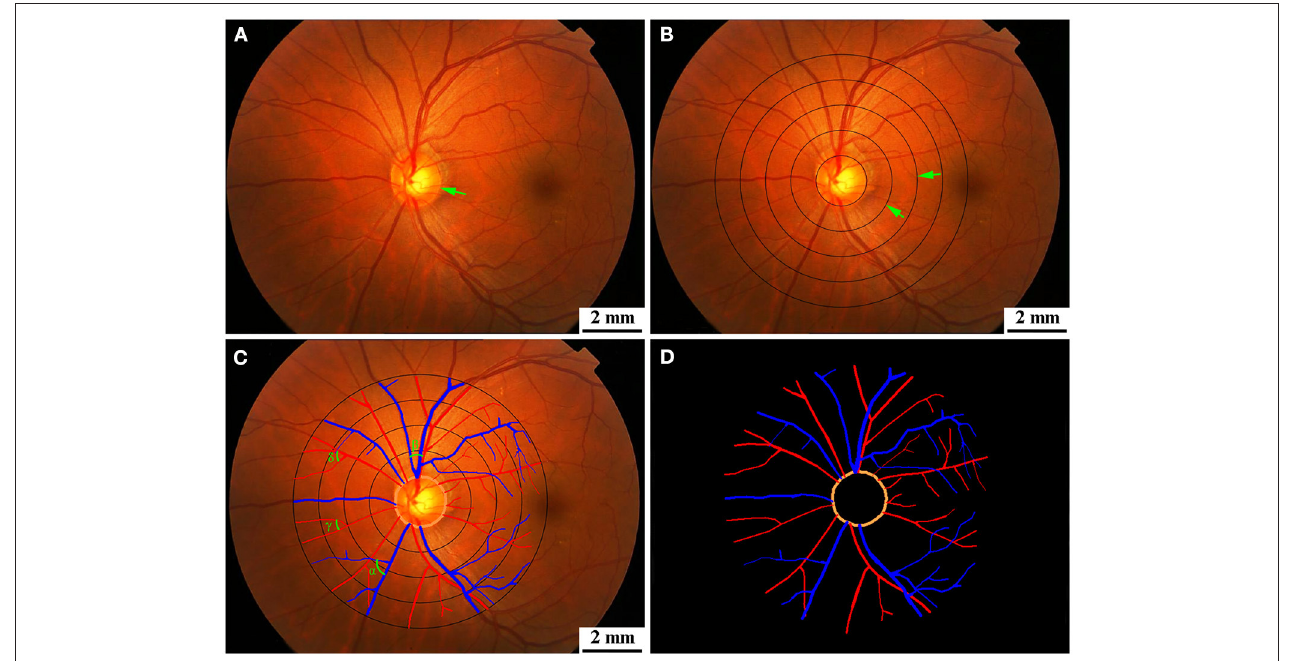
FIGURE 2 | (A) Original diagram. The green arrow showed optic disk. (B) Retinal photographs graded by Canvus 14, drew concentric circles within the scope of 0.0–2.0 DD from the optic disk margin per interval distance 0.5 DD. The green arrows showed concentric circles. (C) Retinal photographs graded by NeuroLucida. Arteries are traced as red line, and veins are traced as blue line. The branching angles of vessels are shown as α , β , γ , and δ in (C) . (D) Segmentation of retina vessels. DD, disk diameter.